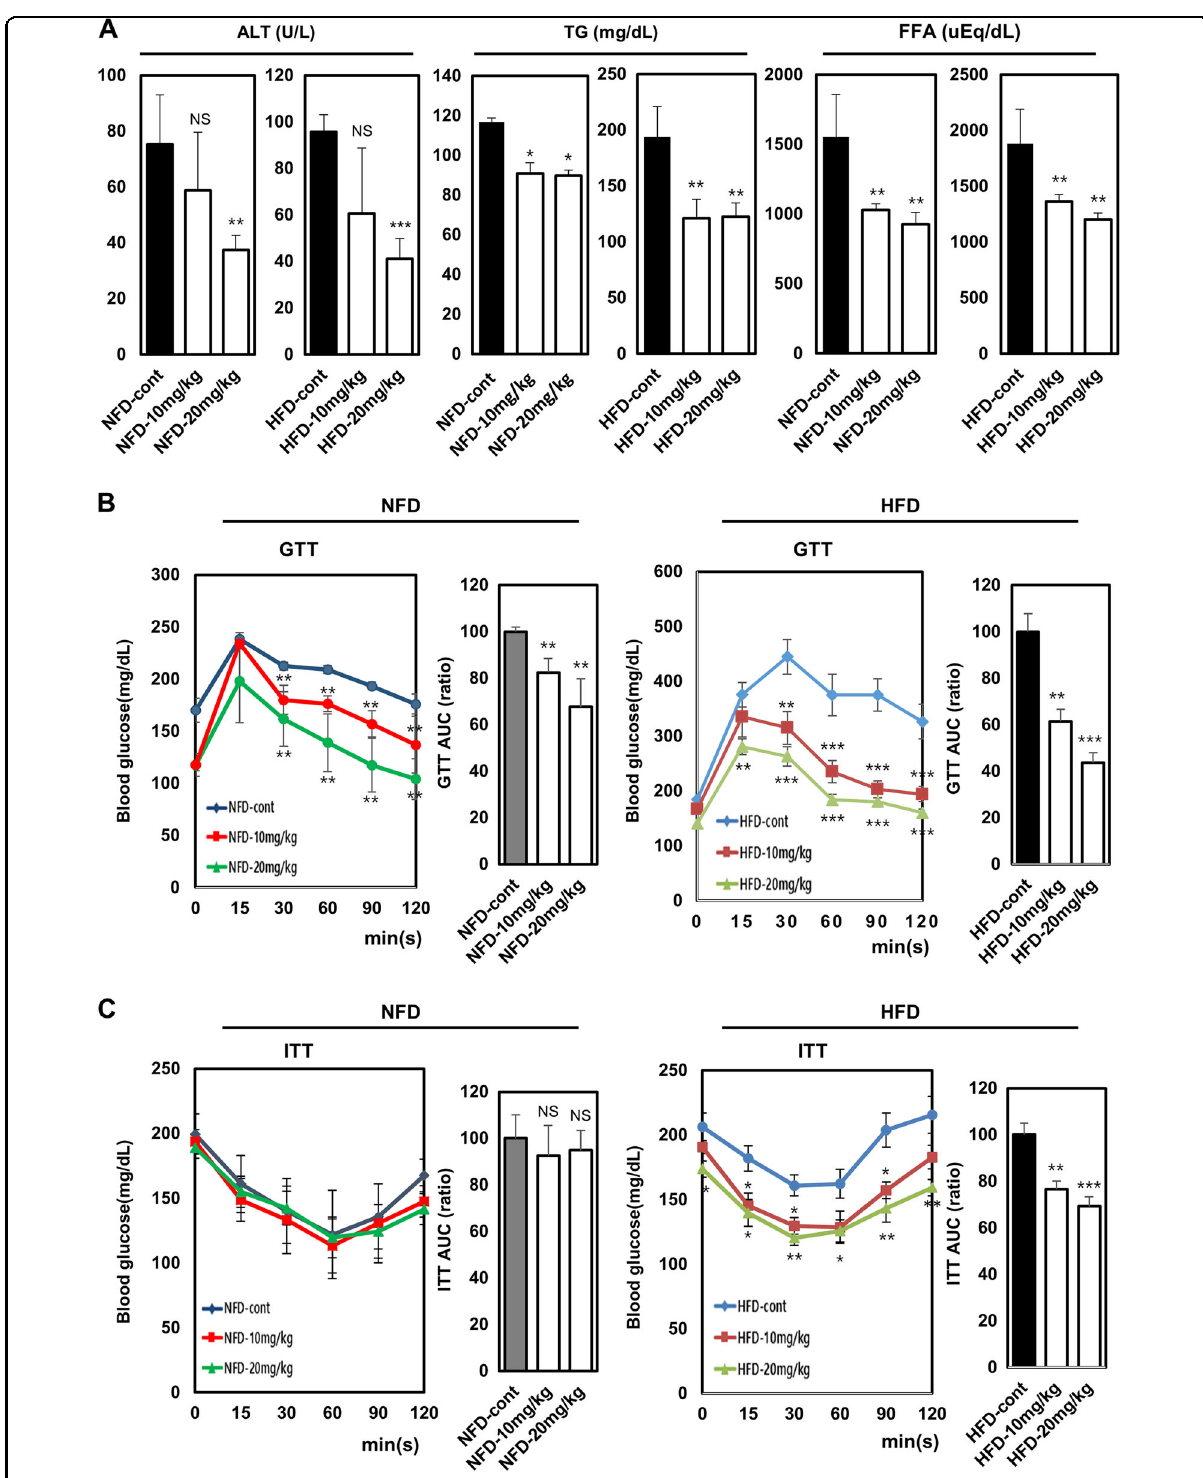
Fig. 5 Vinpocetine improves serum metabolic parameters and glucose homeostasis. a Serum analyses of TG, FFA, and ALT were performed as described in the “ Materials and methods ” . b For glucose tolerance tests, 1 g/kg glucose was intraperitoneally injected into both the NFD-fed and HFD- fed mice. c For insulin tolerance tests, 1 U/kg insulin was intraperitoneally administered into both the NFD-fed and HFD-fed mice. The blood glucose level was measured at different time points as described in the “ Material and methods ” . Data are presented as the mean± SD ( n = 4 for NFD-fed mice and n = 8 for HFD-fed mice) * P < 0.05; ** P < 0.01; and *** P < 0.001 for untreated control vs. 10 and 20mg/kg